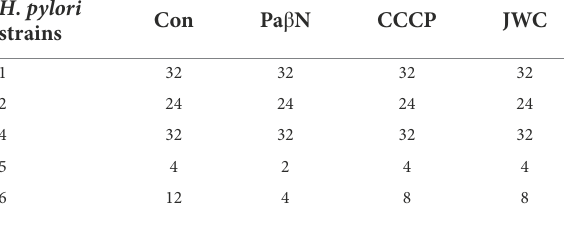
TABLE 6 Effects of JWC on MIC ( μ g/ml) of CLA resistant